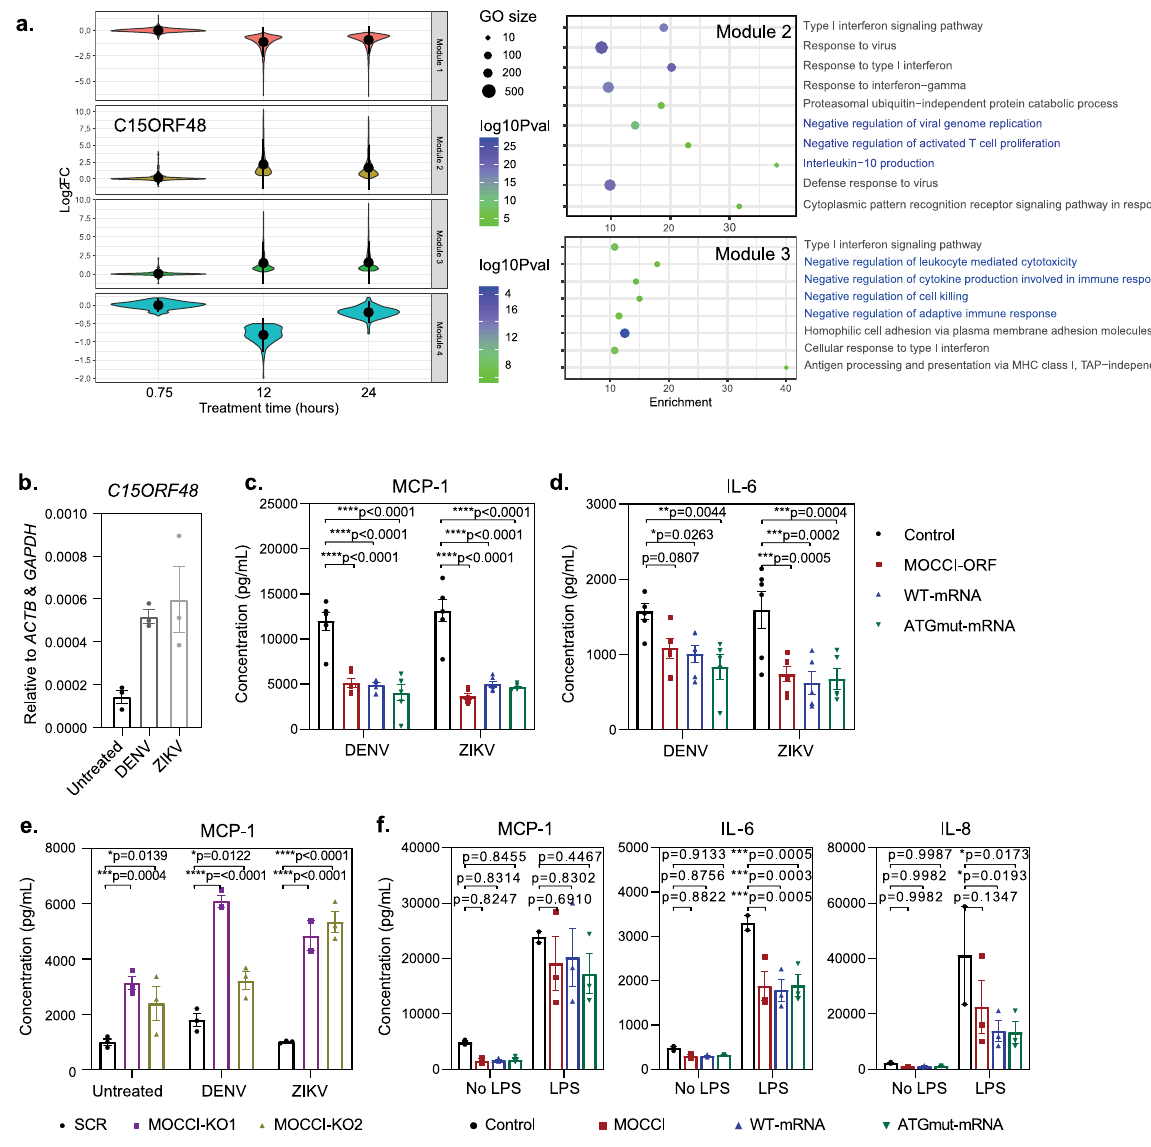
Fig. 7 MOCCI and miR-147b reduce MCP-1 and IL-6 secretion during viral infection. a (Left) Differentially expressed genes in the HAECs treated with IL- 1 β across the timepoint series (Fig. 1b) were clustered into co-expression modules by dynamic tree cut. The log-fold change is relative to the untreated cells. C15ORF48 resides in Module 2. (Right) Panther GO analysis of genes in Module 2 and closely related Module 3 reveal signi fi cant enrichments in the ontologies depicted. Size of dot indicates the number of members in each GO annotation and the color indicates the p value of enrichment. b C15ORF48 mRNA levels in HAECs following DENV and ZIKV infection. Data were presented as mean ± SEM; n = 3 biological replicates per condition. c Levels of MCP-1 (CCL2) secreted by HAECs with indicated transgenes following DENV/ZIKV infection. Data were presented as mean ± SEM; P = two-way ANOVA; n = 6 biological replicates per condition. d Levels of IL-6 secreted by HAECs with indicated transgenes following DENV/ZIKV infection. Data were presented as mean ± SEM; P = two-way ANOVA; n = 6 biological replicates per condition. e Levels of MCP-1 (CCL2) secreted by WT and MOCCI-KO HAECs at basal and following DENV/ZIKV infection. Data were presented as mean ± SEM; P = two-way ANOVA; n = 3 biological replicates per condition. f Levels of MCP-1 (CCL2), IL-6, and IL-8 secreted by HAECs with indicated transgenes at basal and following LPS treatment after 24 h. Data were presented as mean ± SEM; P = two-way ANOVA; n = 3 biological replicates per